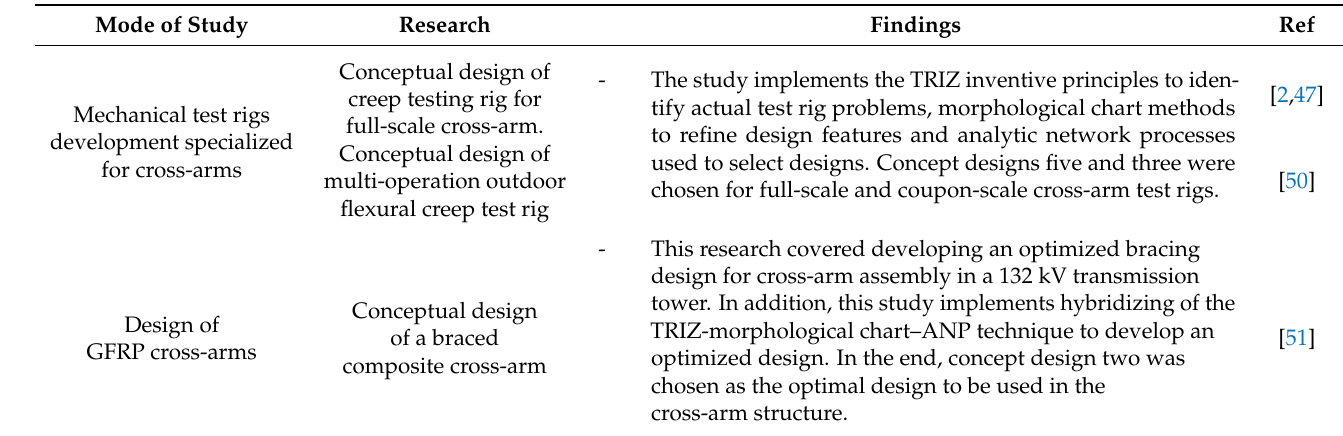
Table 1. Current research progresses of GFRP composite cross-arm